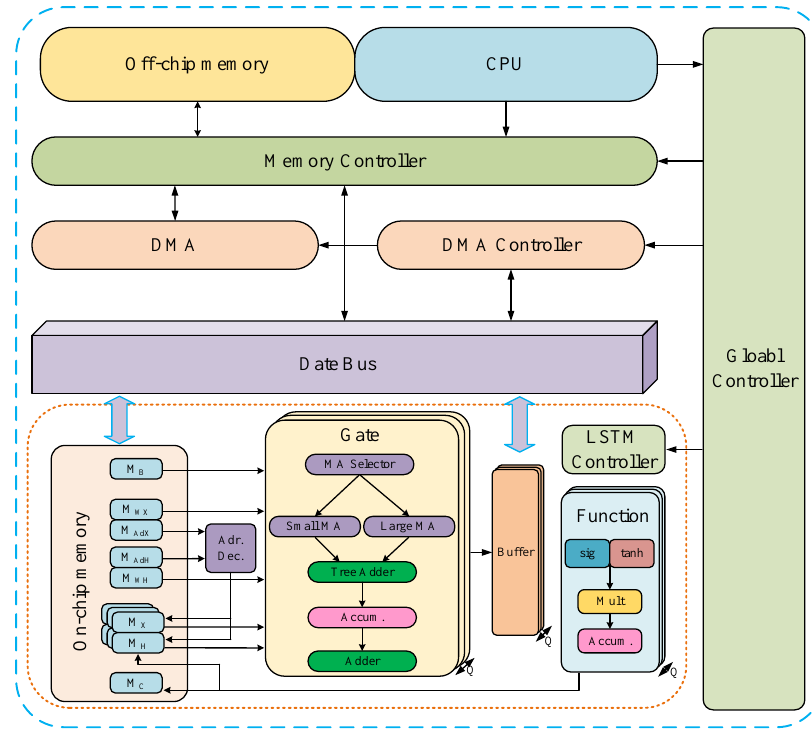
Figure 17. BRDS: FPGA accelerator for speech recognition.